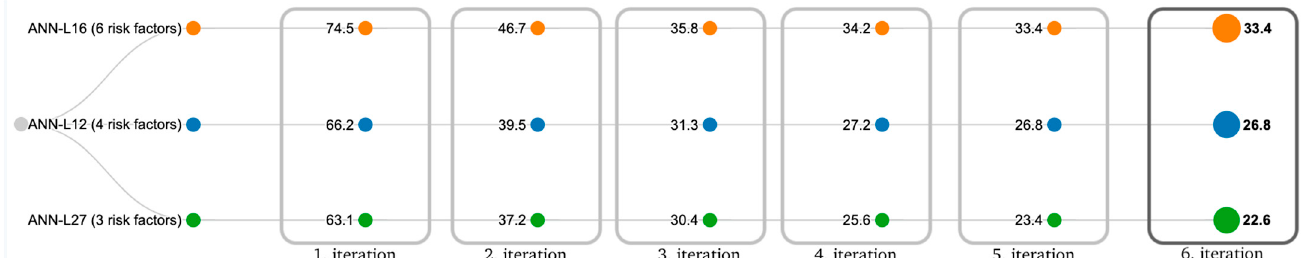
Figure 7. Monitoring of the value of the total risk for the occurrence of hyperinsulinemia within the framework of all three proposed ANN-L models (ANN-L12, ANN-L16, ANN-L27), on the total sample through six iterations.